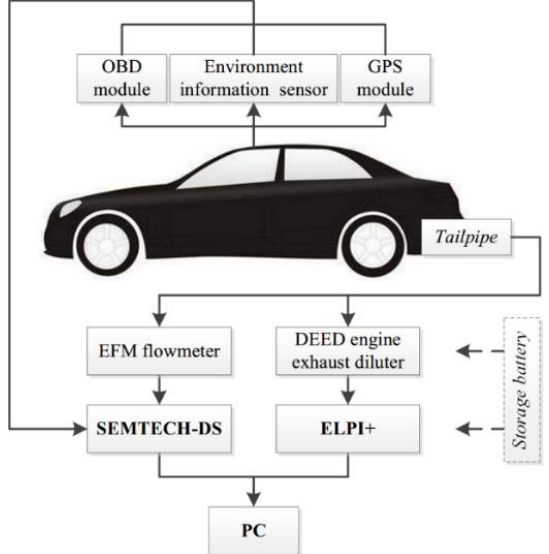
Figure 3. The composition of PEMS and its real installation example.